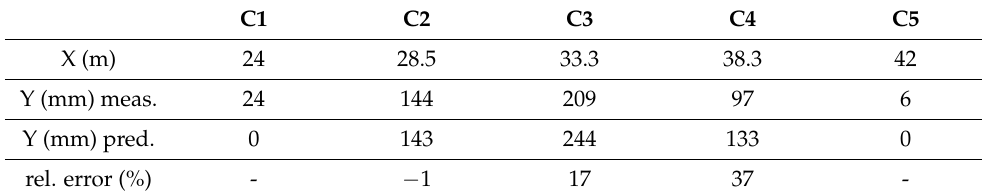
Figure 13. Test 1: predicted and measured deformed configuration. Table 2. Test 1: predicted and measured